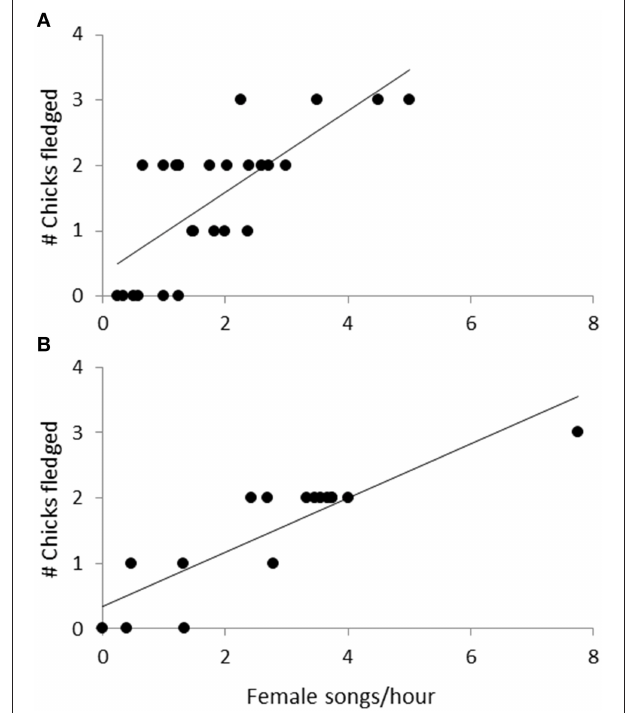
TABLE 3 | Results of generalized linear models relating fledging success to song and provisioning rates, and song structure. FIGURE 5 | The relationship between the number of chicks fledged and female song rate during (A) incubation ( n = 16, 66 observation hours), Effects Estimate ± SE and (B) chick-rearing ( n = 26, 116 observation hours). The line is from a regression.